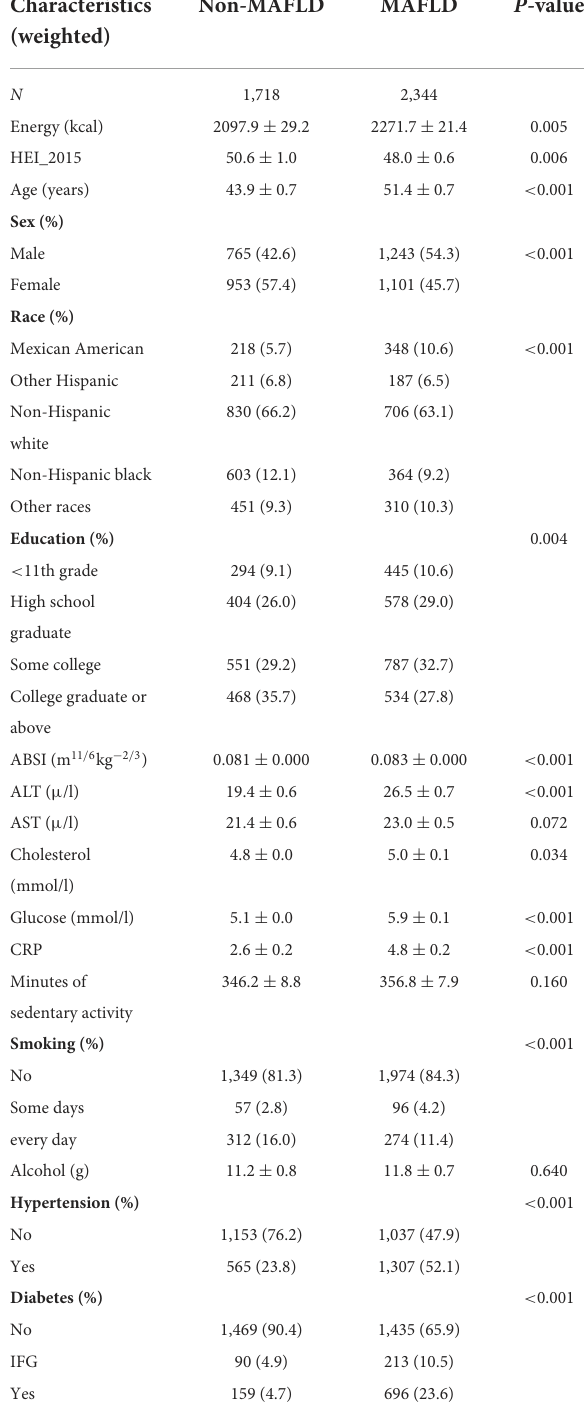
TABLE 1 Characteristics of participants by categories of MAFLD: NHANES 2017–2018.